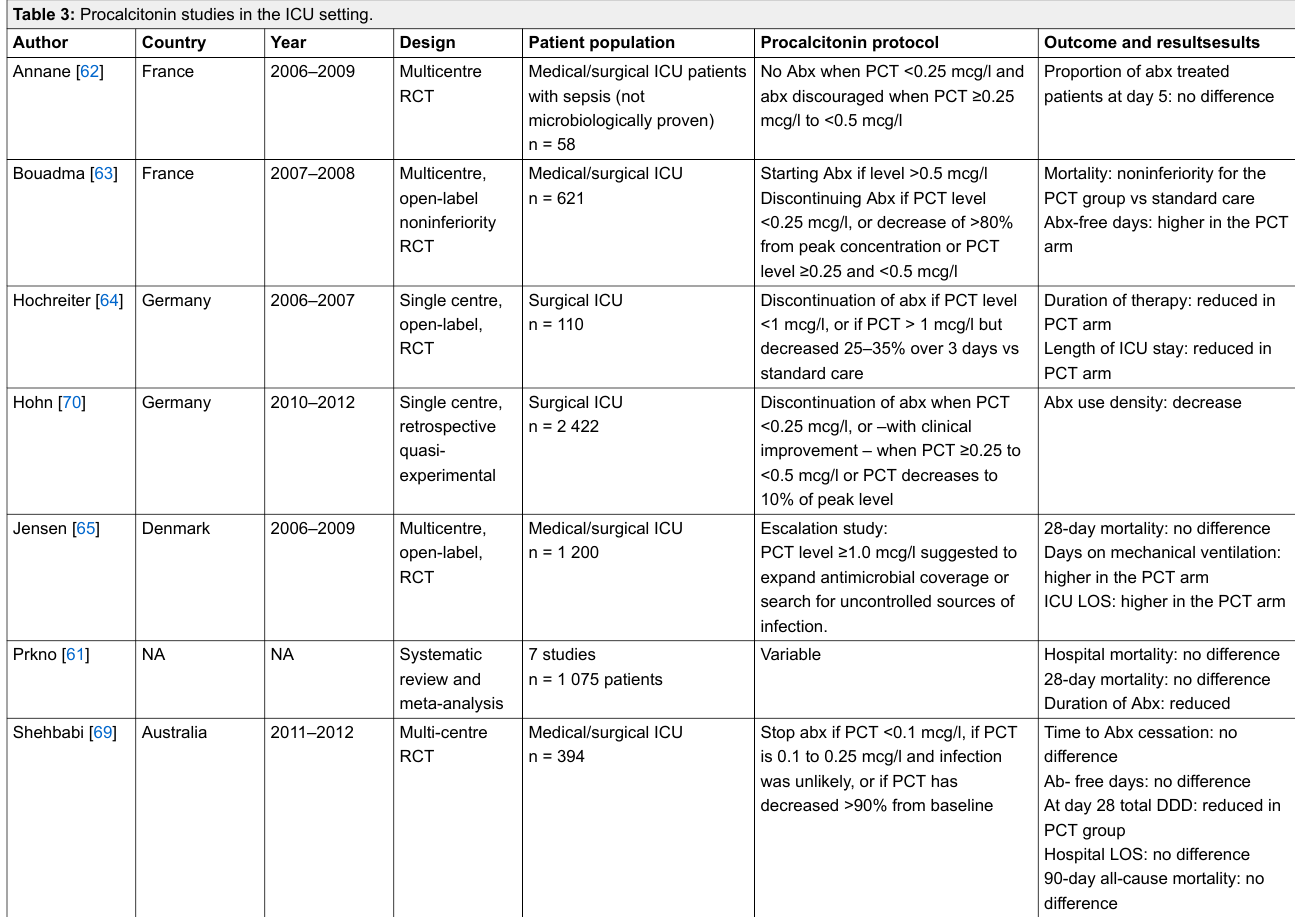
Table 3: Procalcitonin studies in the ICU setting.